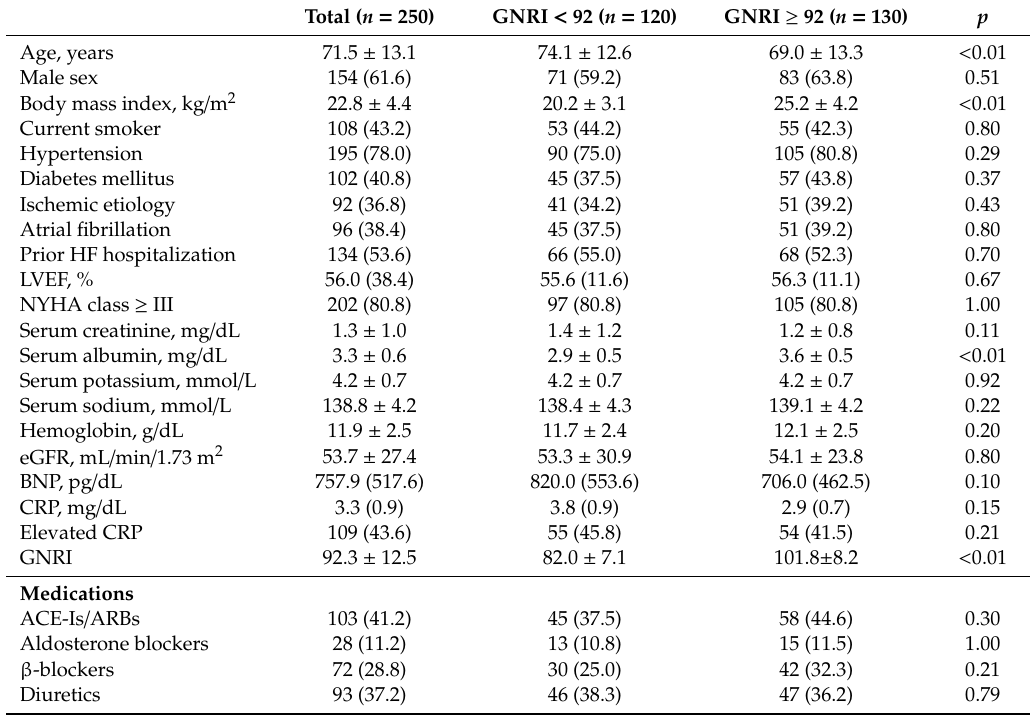
Table 4. Characteristics of patients with